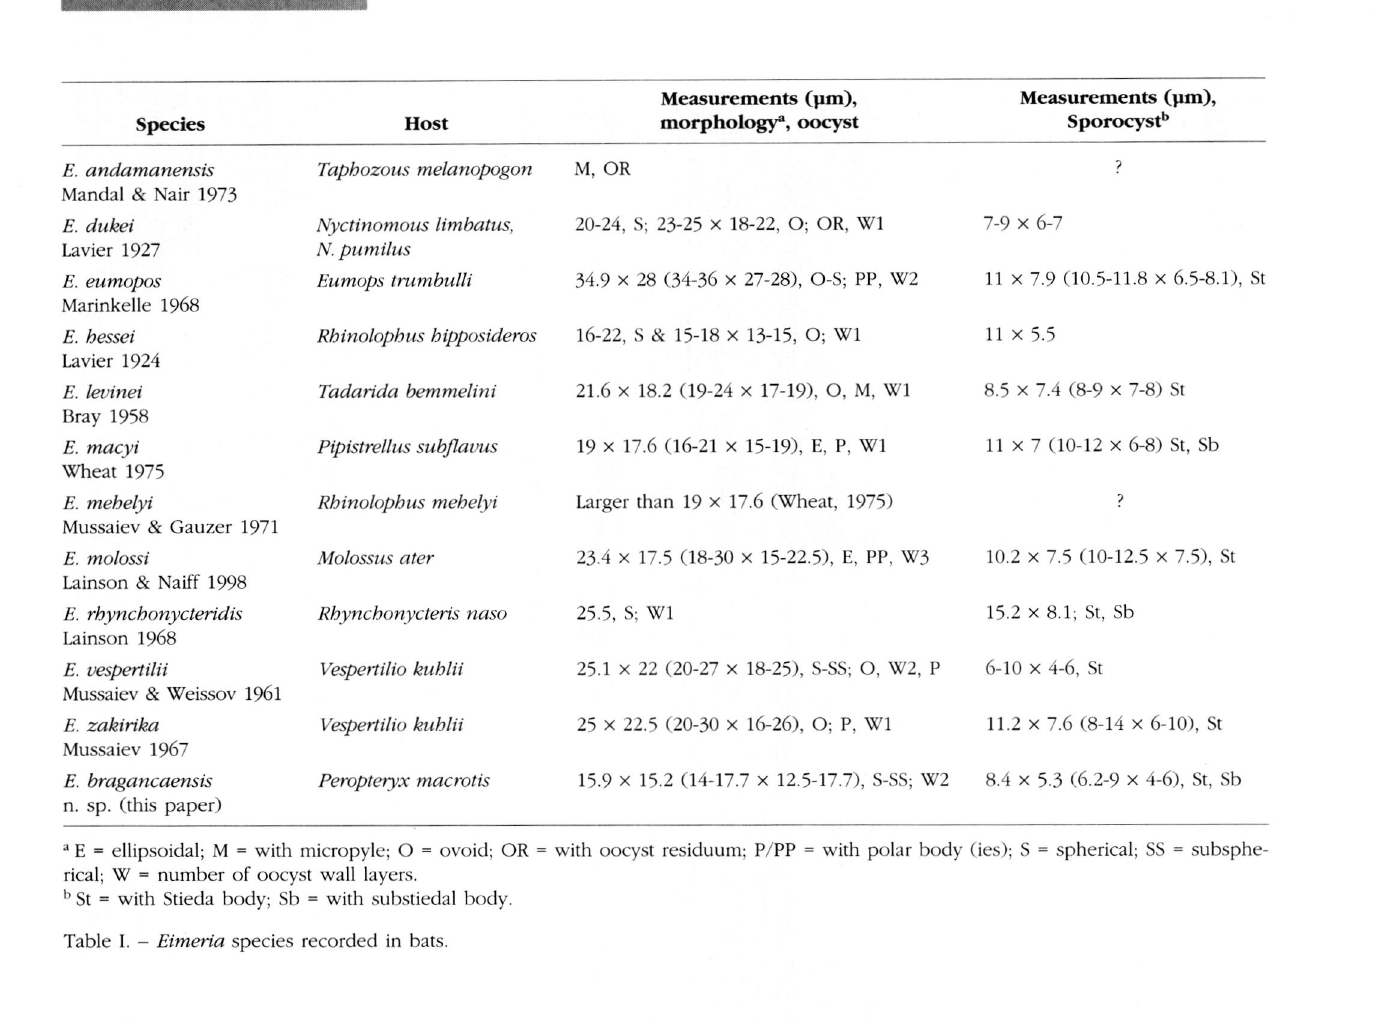
endogenous stages of E. macyi were not